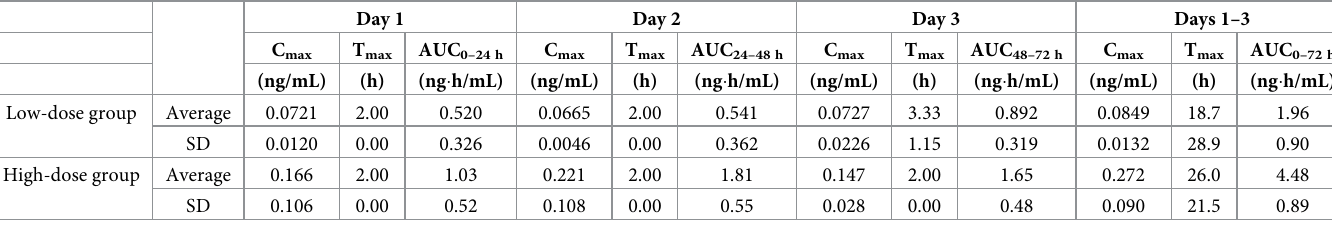
Table 5. Pharmacokinetic parameters of KUS121 after intravitreal